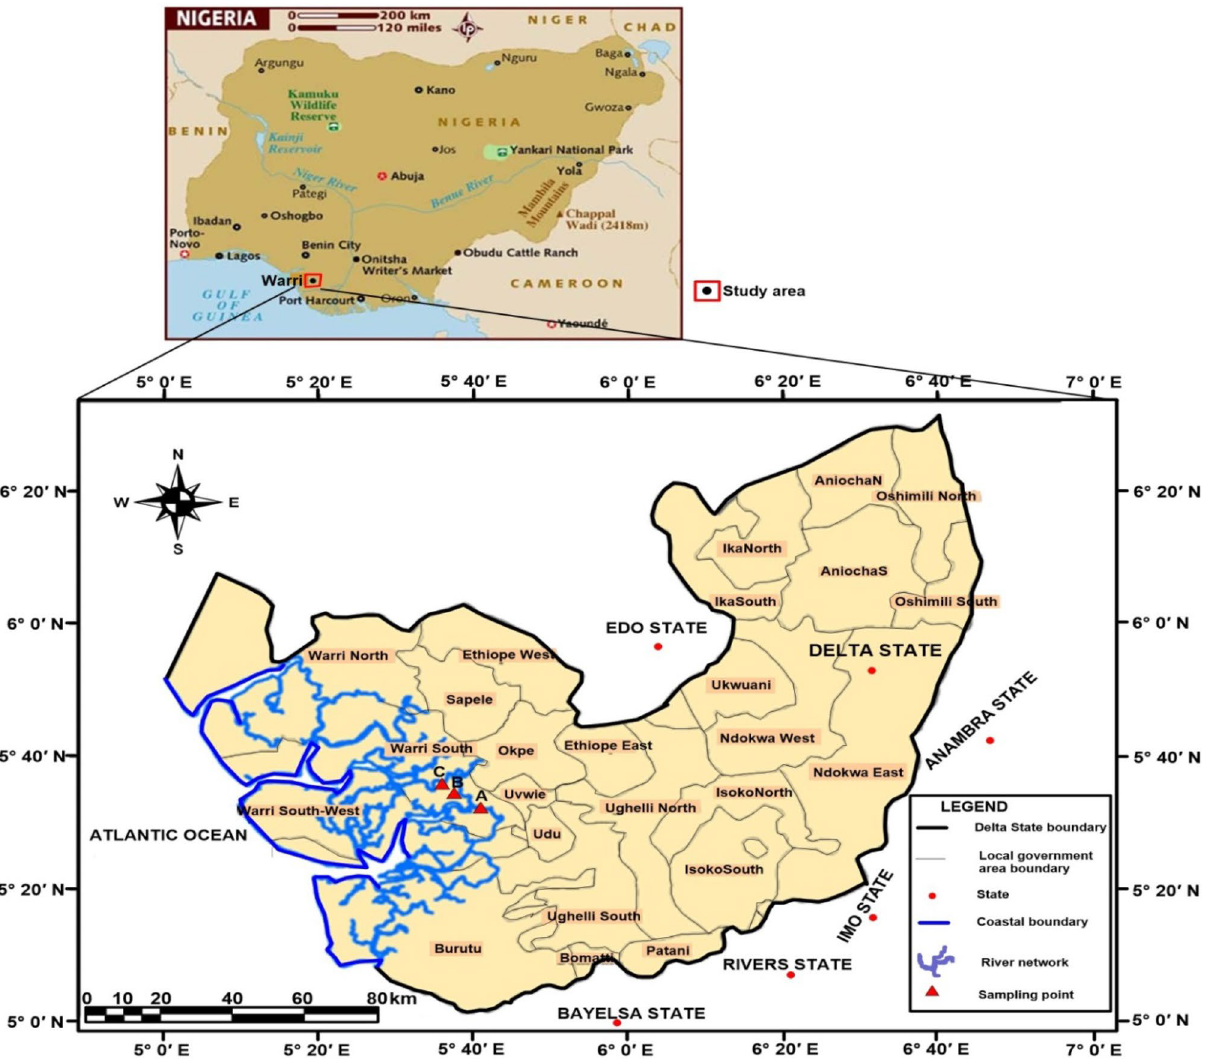
Figure 1. Map of the study area showing sampled stations. Map designed using QGIS software version 3.10.1 ’A Coruña’ (QGIS Development Team 29 ). https ://qgis.org/en/site/forus ers/downl